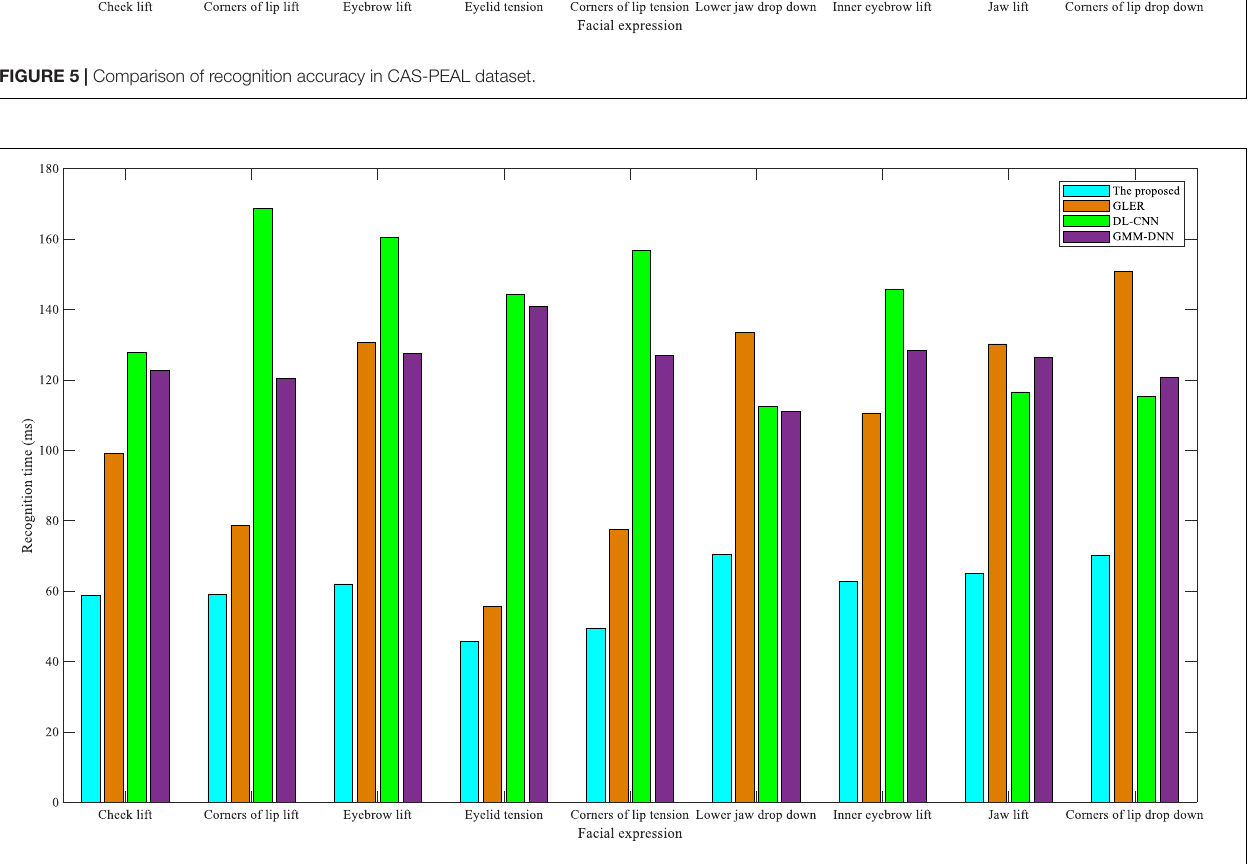
FIGURE 6 | Comparison of recognition time in CAS-PEAL